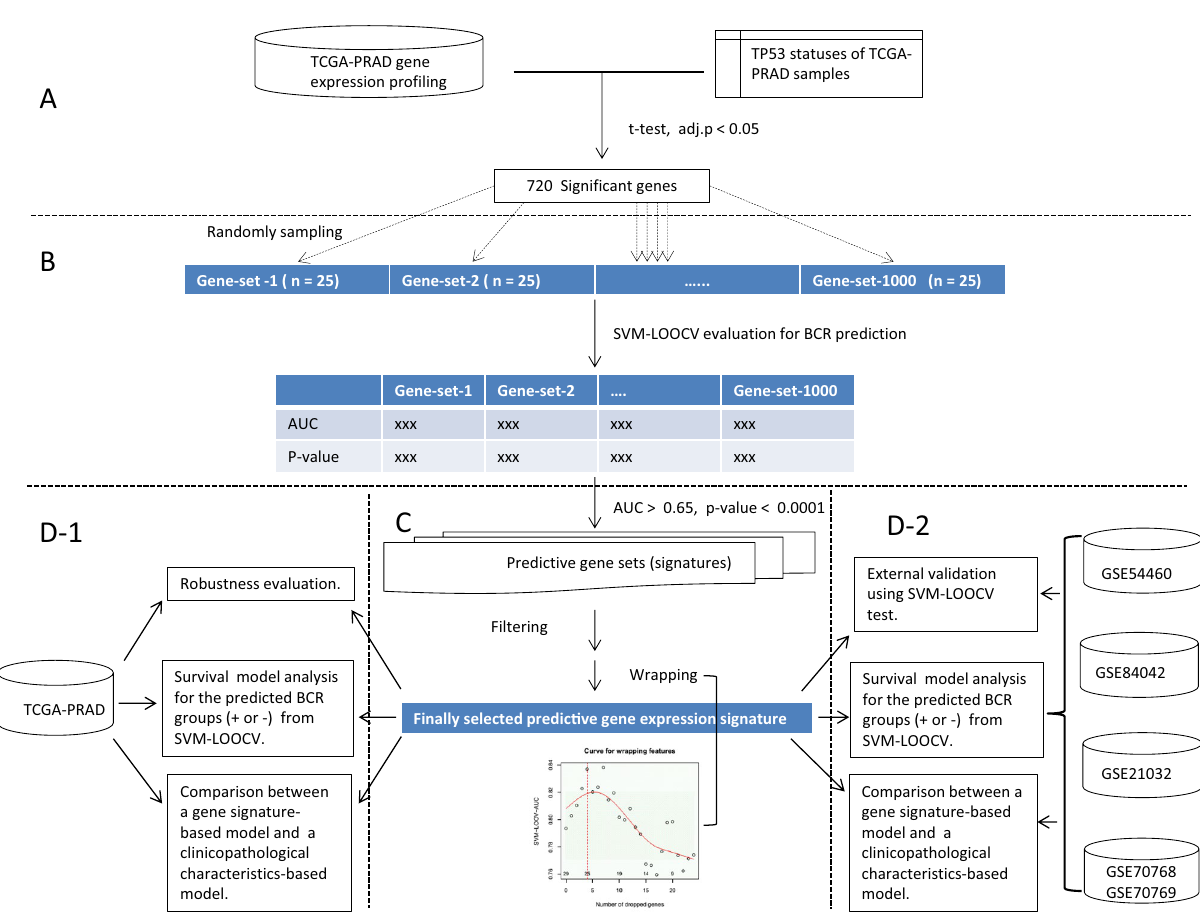
Figure 1. Flow chart of the identification approach ( A,B , C ) and performance/utility evaluation ( D-1 , D-2 ) of a TP53 mutation status-associated predictive transcriptomic signature for BCR. In A , the top differentially expressed genes (DEGs) regarding TP53 statuses were identified. In ( B ), 1000 small subsets of the DEGs were randomly sampled and their predictive strengths for BCR were assessed by SVM-based cross validation. In ( C ), the results from ( B ) step were integrated by a “filter” and a novel “wrapper” to obtain an optimized gene signature. In ( D1 ) and ( D2 ), the performance of the finally selected signature for BCR prediction and the clinical utility were evaluated in the TCGA dataset and five external datasets using statistical and machine learning methods. See the main text for a more detailed